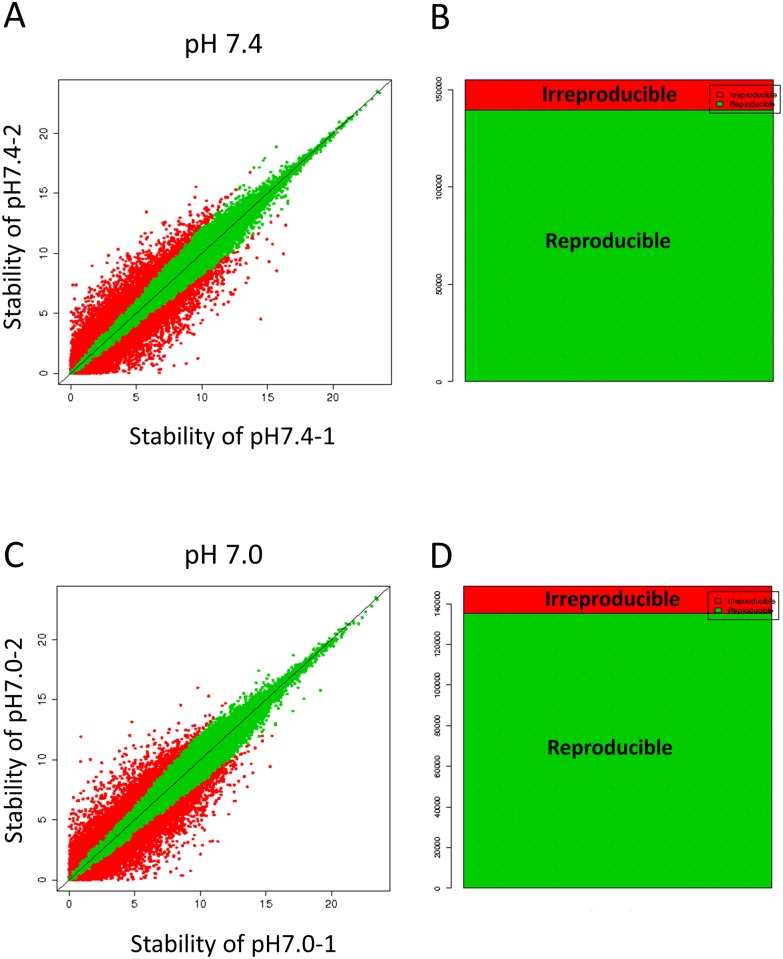
Stability and reproducibility of the biological duplicates.(A and C) The correlations of the expression values between duplicates 1 and 2 at pH 7.4 and pH 7.0, respectively. Green dots indicate high reproducibility and red dots indicate low reproducibility. (B and D) The numbers of reproducible or irreproducible TSS clusters between the duplicates. Green and red bars represent the reproducible and the irreproducible clusters, respectively.